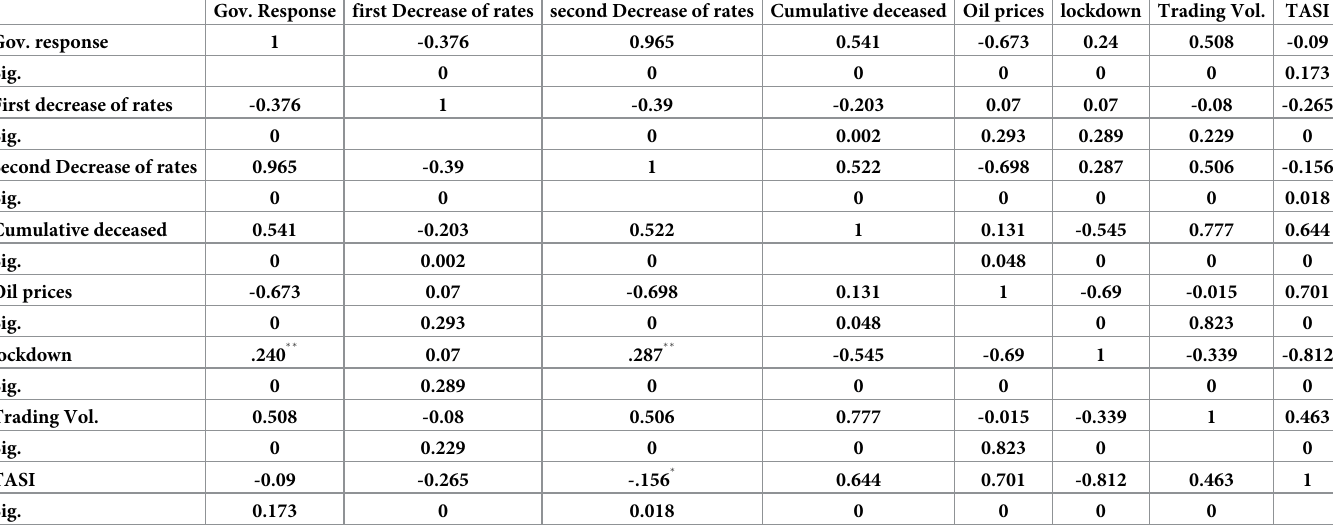
Table 2. Descriptive statistics of main